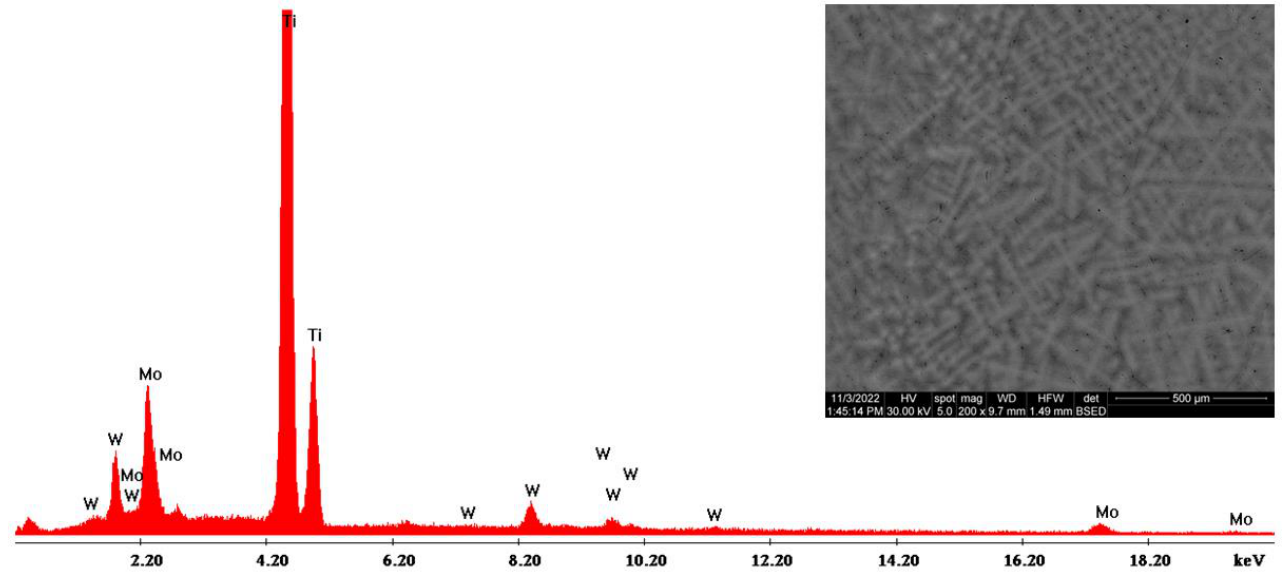
Figure 10. SEM—EDS characterization of Ti19Mo10W alloy (Code 4). Table 4. Values of the main electrochemical parameters determined in the corrosion